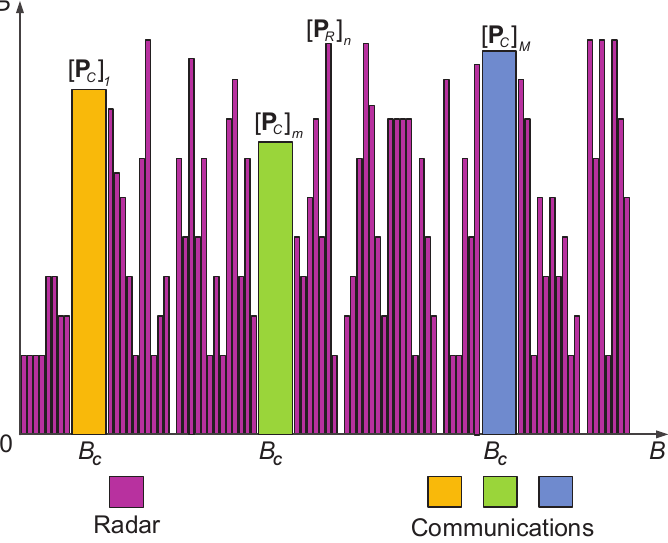
and [ p R ] are the transmit powers assigned m n